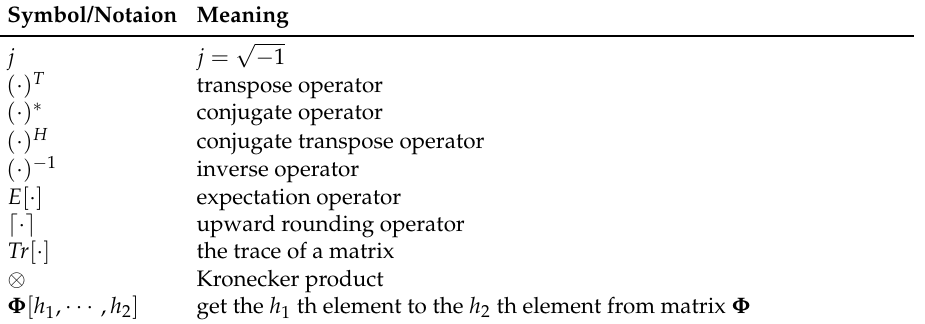
Table 2. Meaning of symbol and notation used in the paper.